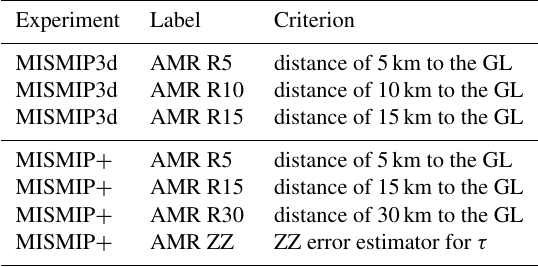
Table 2. Levels of refinement tested in the